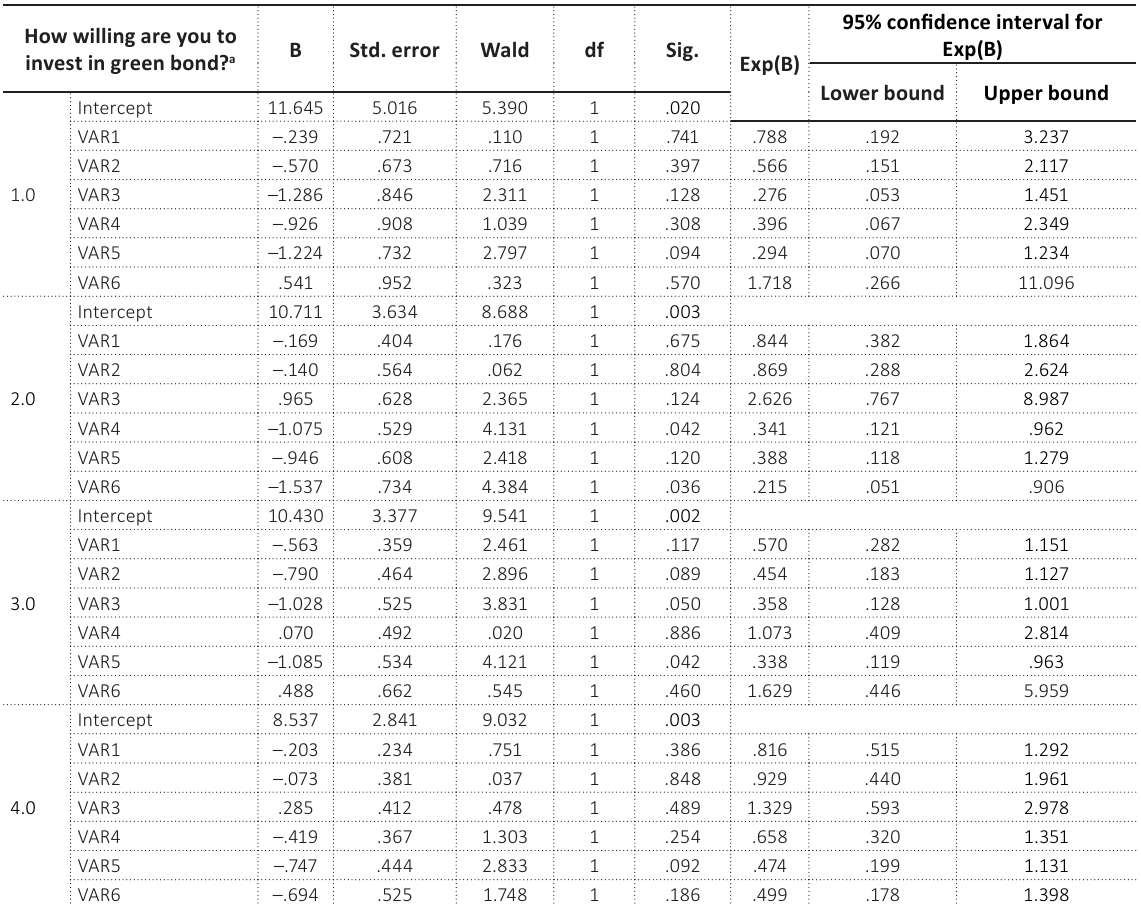
Table 5. Multinomial logistic regression output How willing are you to invest in green bond? a